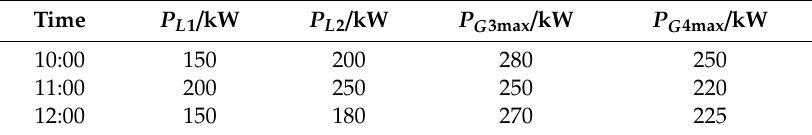
Table 1. The predicted value of virtual power and virtual load for 10:00–12:00.